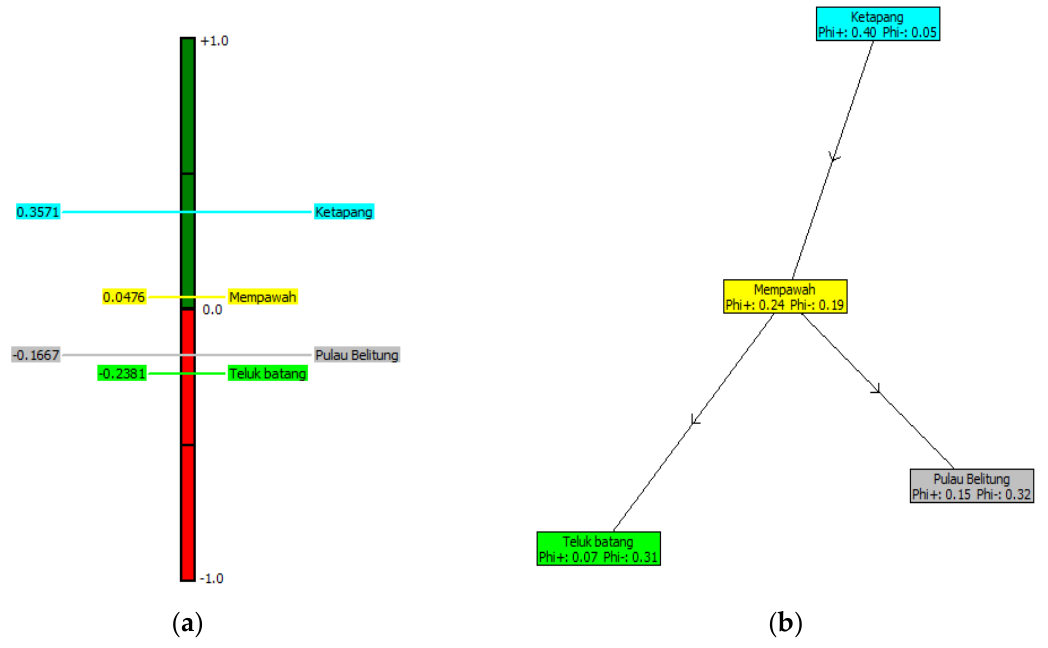
Figure 4. ( a ) Ranking PROMETHEE; ( b ) net flow from four pilot plant site selections.